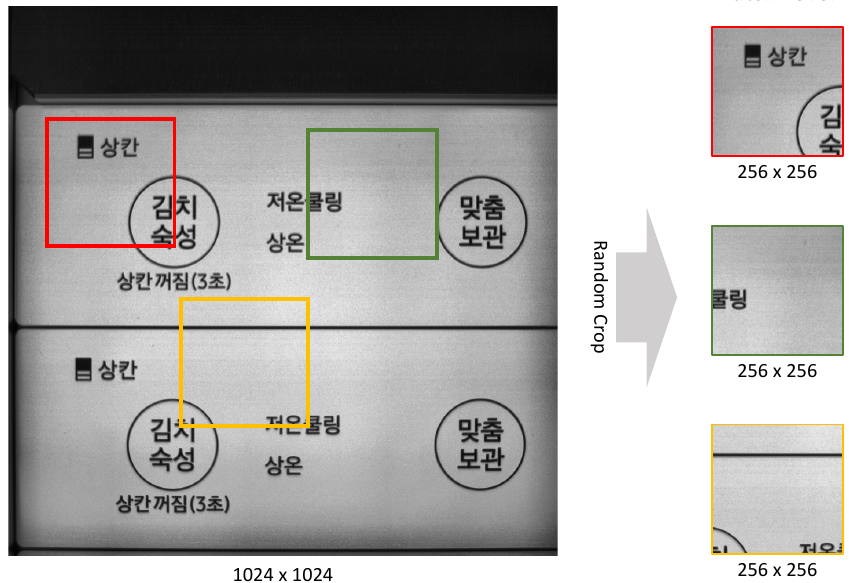
Figure 7. Proposed detailed learning method.